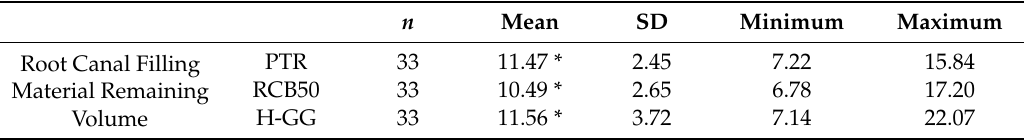
* Statistically significant di ff erences between groups ( p < 0.05). PTR: ProTaper Retreatment endodontic rotary instruments; RCB50: Reciproc Blue endodontic reciprocating instrument; H-GG: combined root canal retreatment technique between Gates-Glidden drills and Hedstrom